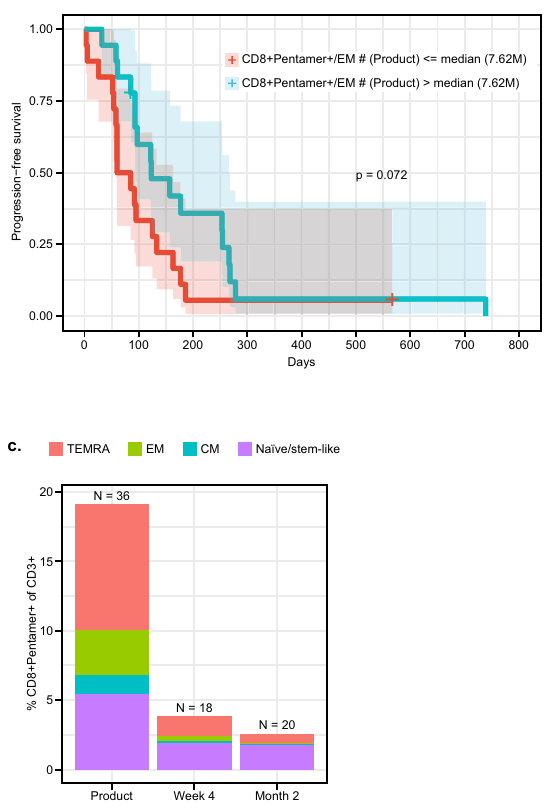
Fig. 4 | Characterization of transduced T cells post infusion. a Association of % and number of CD8+ Pentamer+EM cells/kg with PFS.PFS was de fi ned as the time from T-cell infusion to the earliest documentation of disease progression or death from any cause or surgical resection or start of prohibited medication ( n =36 biologically independent samples). Blue and red shaded areas represent 95% con- fi denceintervalforthesurvivalcurve. b LevelsofCD8+Pentamer+cellsatWeek4. c Levels and composition of memory phenotypes of CD8+Pentamer+ cells post- infusion. Product analyses consist of 36 patients. Number of patients for post- infusion analyses are listed on fi gures. Box plots depict median as horizontal line within box, with box bounds as the fi rst and third quartiles. Dots represent